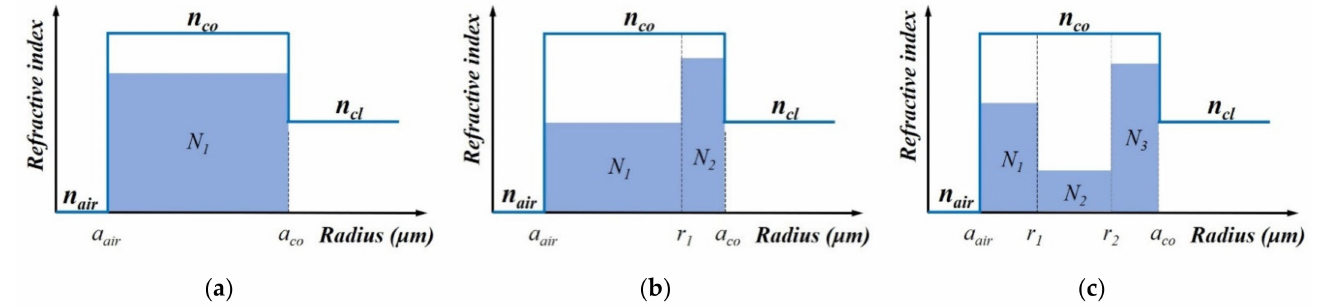
Figure 2. Different doping profile. ( a ) uniform doping; ( b ) double-layer doping; ( c ) triple-layer